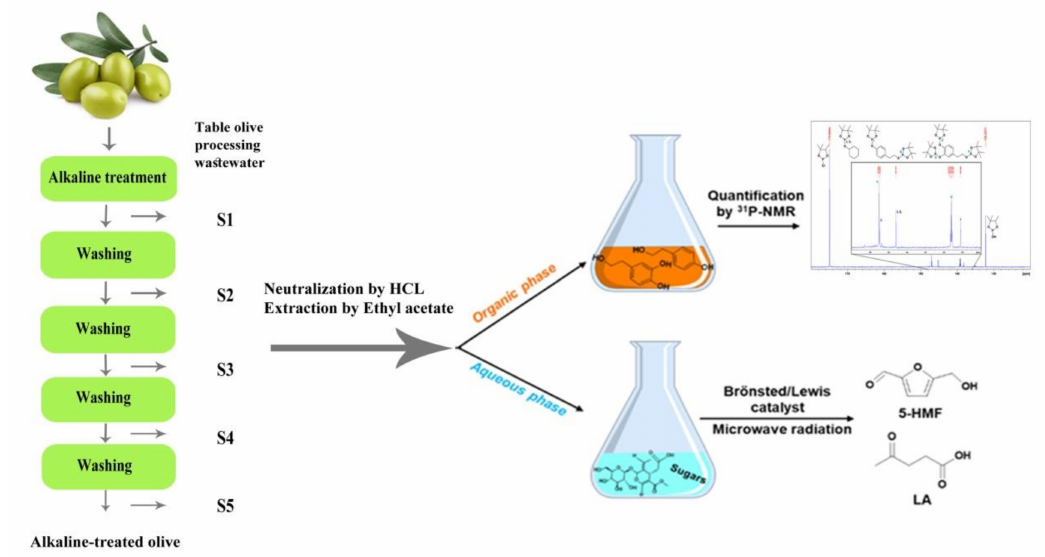
Figure 2. Schematic representation of the valorization of table olive processing wastewater (TOPWW) carried out in this study. As shown in Figure 3, the 1H-NMR spectrum of oleuropein was useful for tracking the ester hydrolysis of oleuropein/ligstroside and analyzing the NMR spectra of both phases after